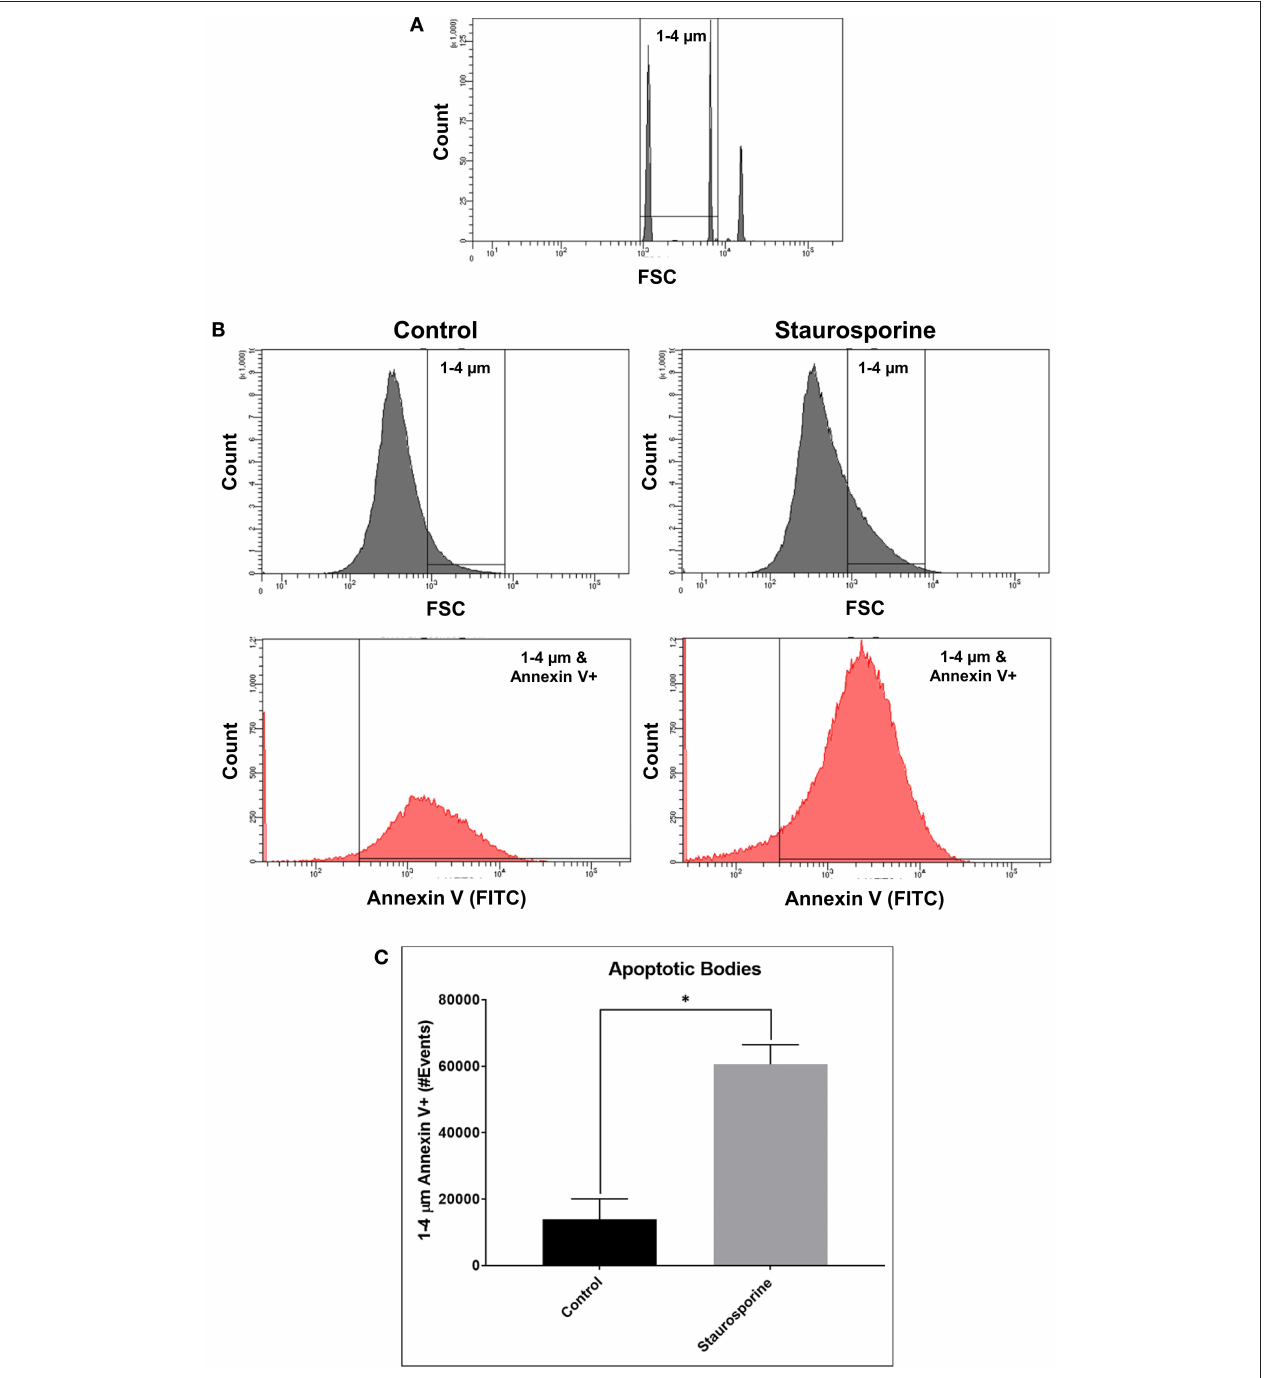
FIGURE 2 | (A) Flow cytometry images of size calibration beads (1, 4, and 6 µ m beads). (B) Representative flow cytometry images indicating process of ABs identification using size gate (1–4 µ m) and Annexin V-FITC staining, from cell culture supernatants after control or Staurosporine (0.5 µ M) treatment. (C) Plot of ABs (1–4 µ m and Annexin V-positive events). The error bars represent standard deviation ( n = 6); data were analyzed using Wilcoxon test, P = 0.031. * p < 0.05.